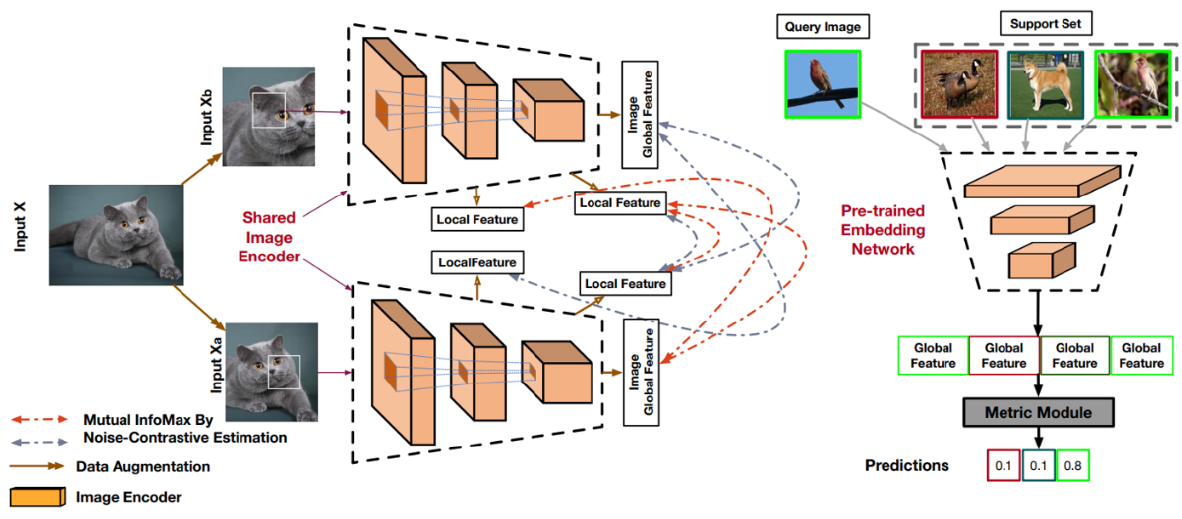
Figure 3. Prototypical network.